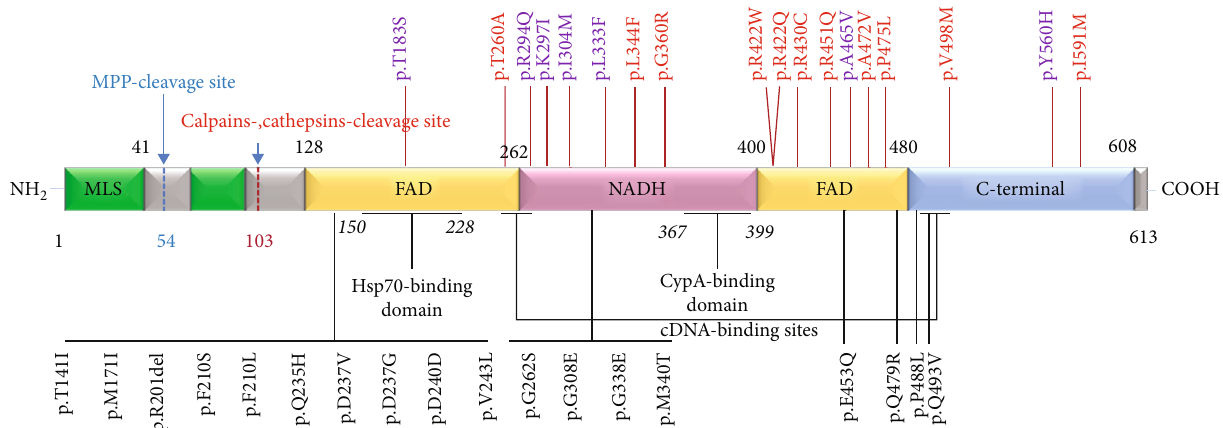
Figure 2: AIFM1 variations in auditory neuropathy as well as other syndromes. The purple ones are the new variations identi fi ed in this study, the red ones are the previously reported AN-related variations, and the black ones are the variants that are related to syndromes such as cerebellar ataxia (modi fi ed from